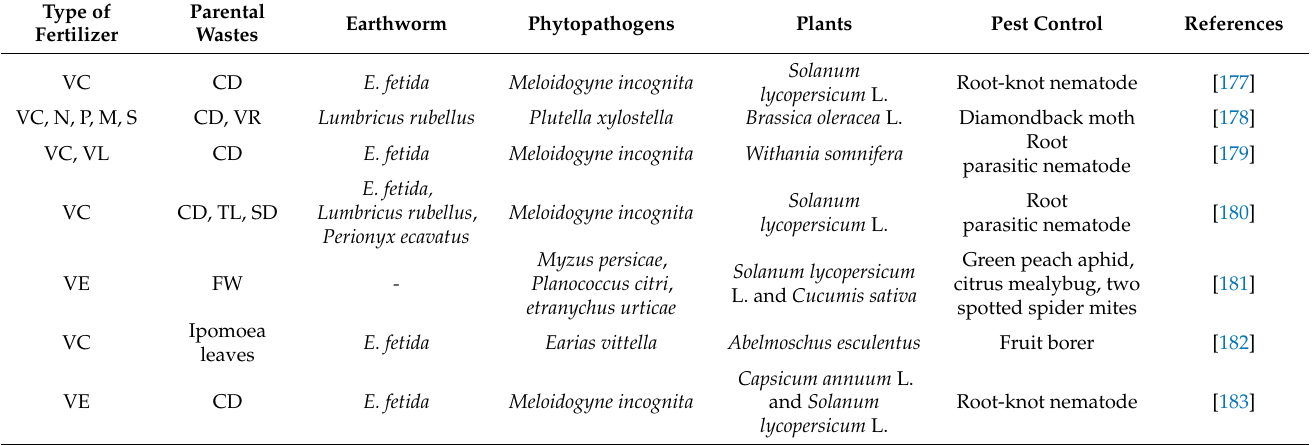
Table 4. Phytopathogen-suppressing potential of vermicompost and its derivatives produced from various waste